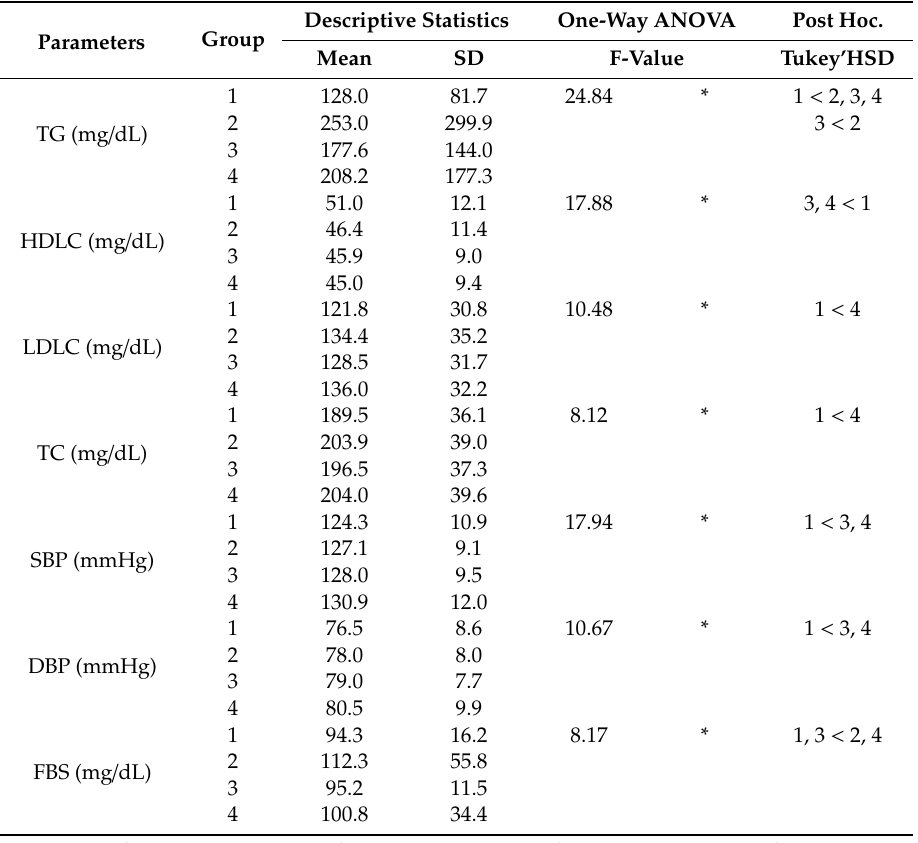
Table 2. The mean levels of cardiometabolic risk factors by